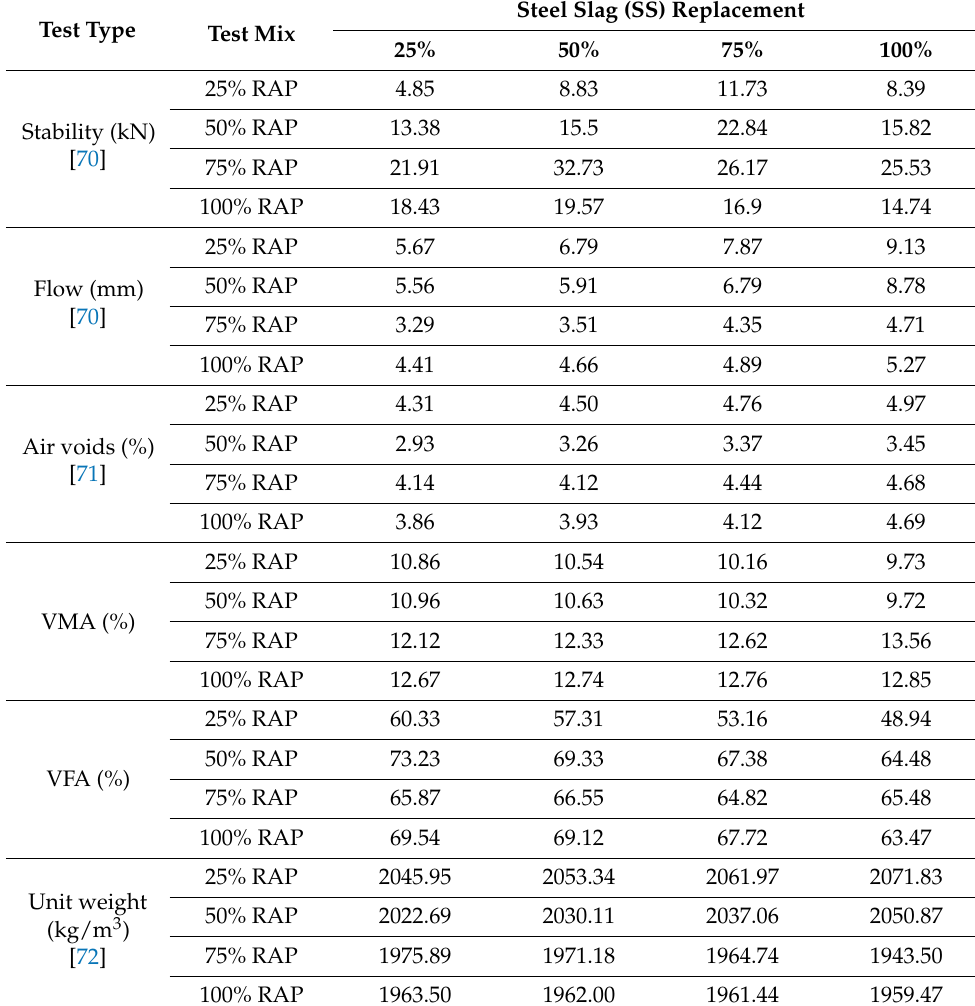
Table 5. Test results for the RAP mixes containing steel